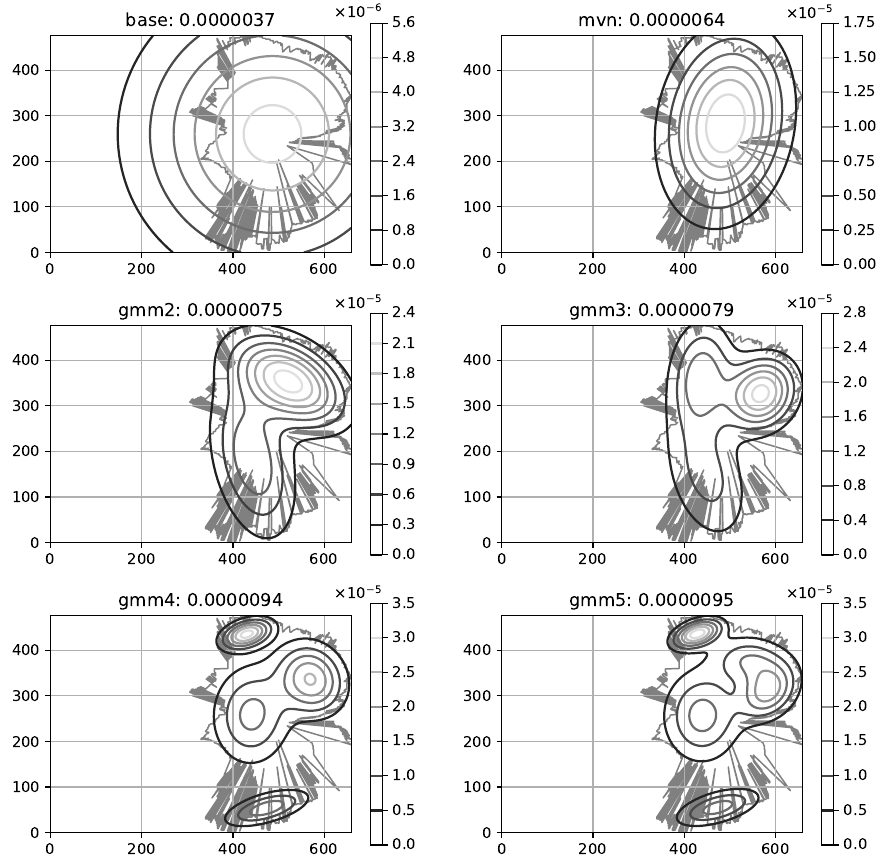
Figure 7. Cell coverage modeling accuracy; an original RF signal coverage area is reflected by a fuzzy polygon; an estimated RF signal distribution is illustrated using contour lines; base is the previously used coverage modeling method, mvn —a single Gaussian multivariate, gmmN Gaussian Mixture Models, where N is the number of